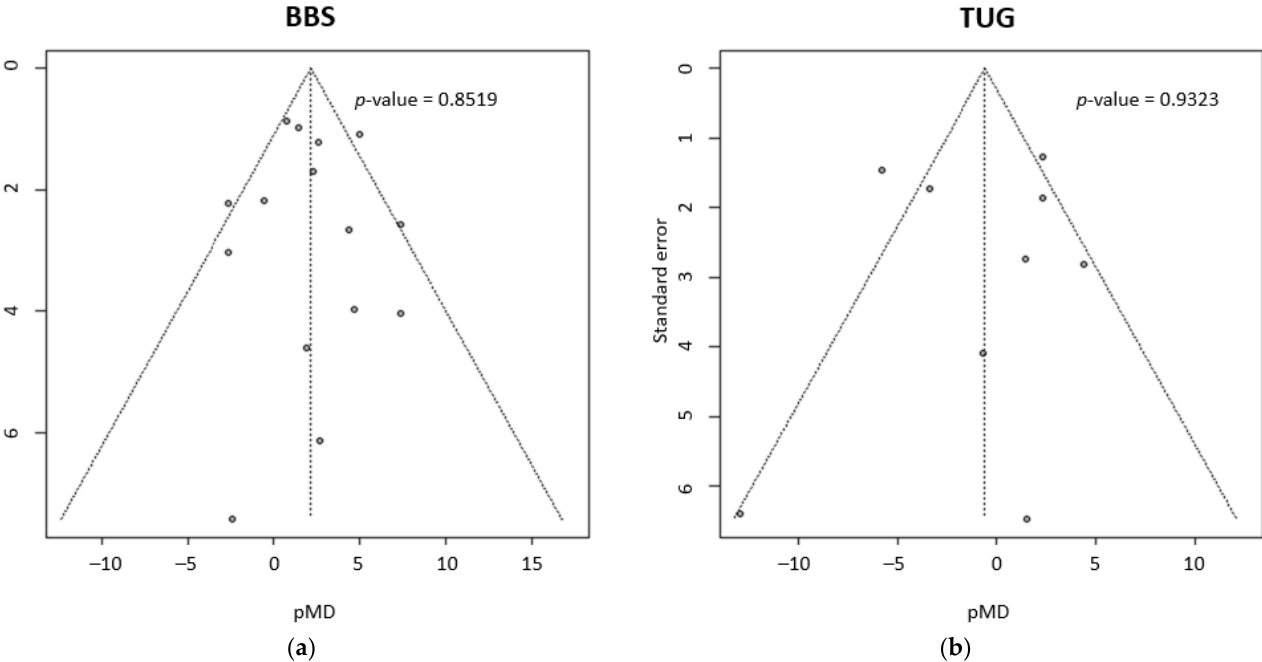
Figure 5. ( a ) Funnel plot that analyses potential publication bias in BBS meta-analysis. On the top right corner, p -value calculated with Egger’s test for publication bias. ( b ) Funnel plot that analyses potential publication bias in BBS meta-analysis. On the top right corner, p -value calculated with Egger’s test for publication bias.